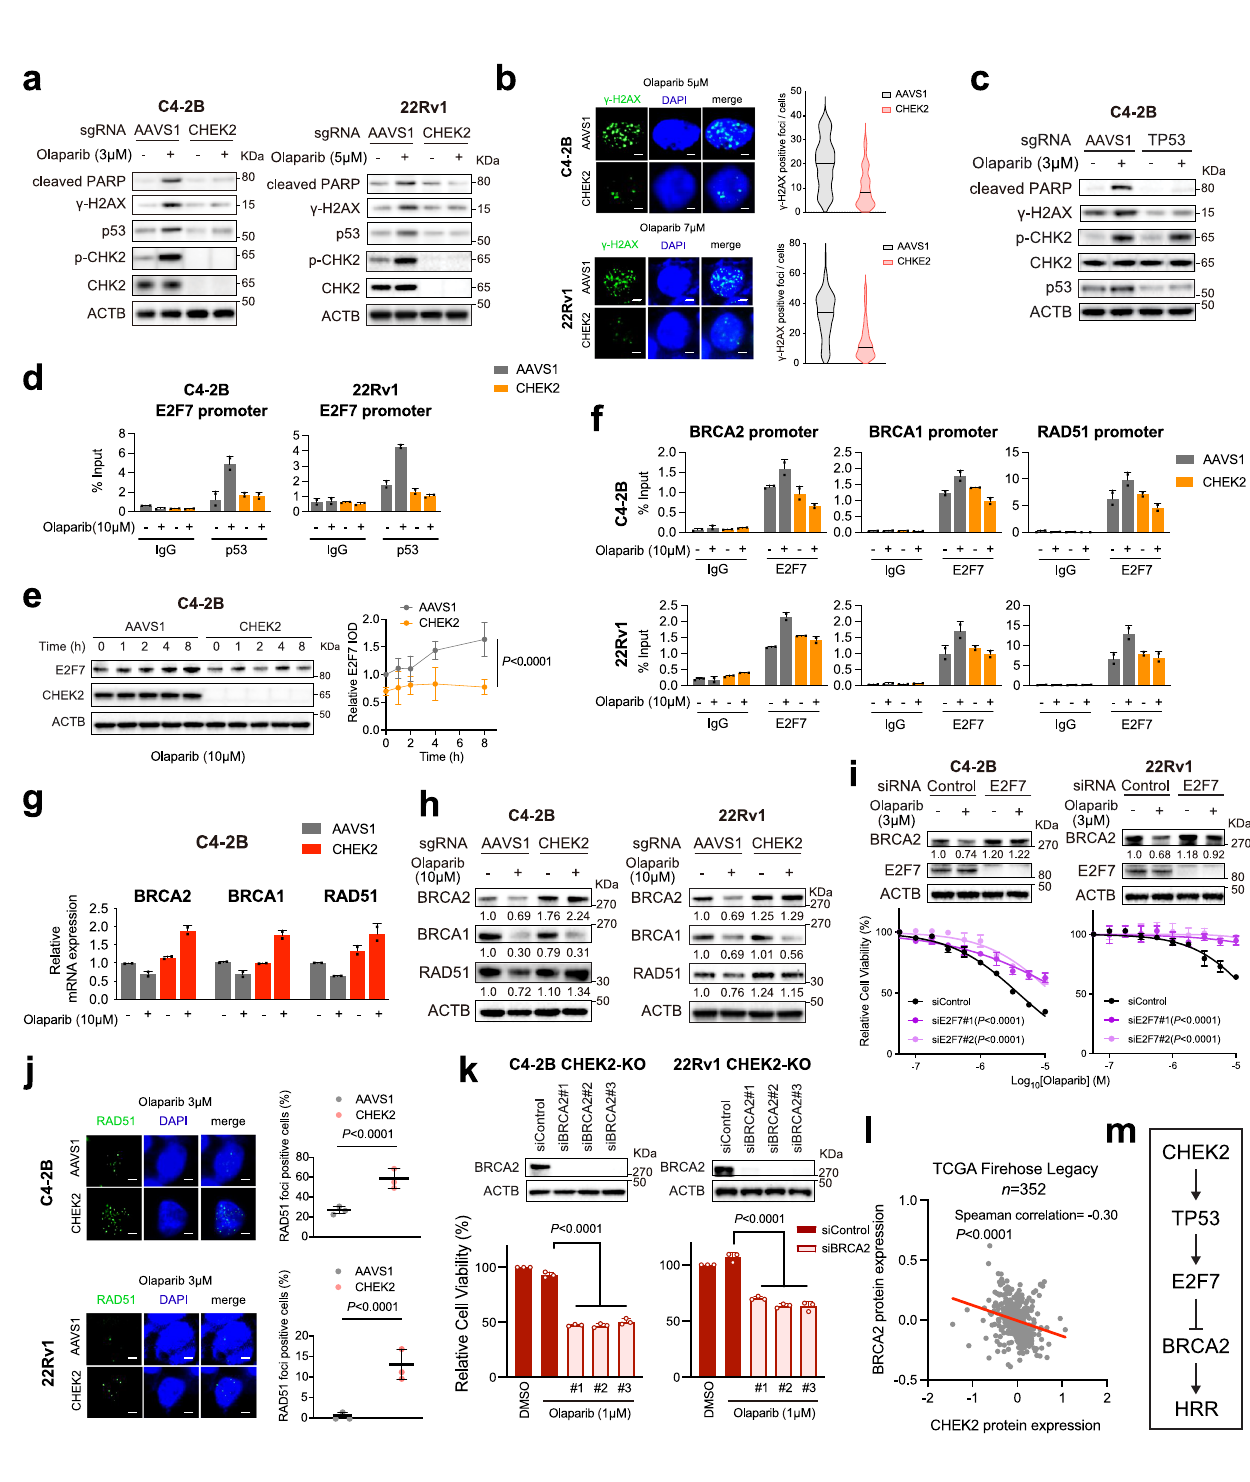
Fig. 6 | Loss of CHEK2 renders PCa cells resistant to PARP inhibition. a Dose- response curves after treatment with olaparib for two AAVS1 control (sg1 and sg2) and two CHEK2 -KO (sg1 and sg2) LNCaP, C4-2B, 22Rv1, DU145, and PC-3 cell lines. TheupperrightpanelineachcelllineistheimmunoblotanalysisshowingtheCHK2 protein level in CHEK2 -KO versus control cells. b Representative colony growth images(upperpanel)andquanti fi cation(lowerpanel)aftertreatmentwitholaparib in AAVS1 control and CHEK2 -KO PCa cell lines as indicated. Data are presented as mean±SD of three biologically independent replicates. The p- values were deter- mined using one-way ANOVA. c Dose-response curves (left panel) after treatment